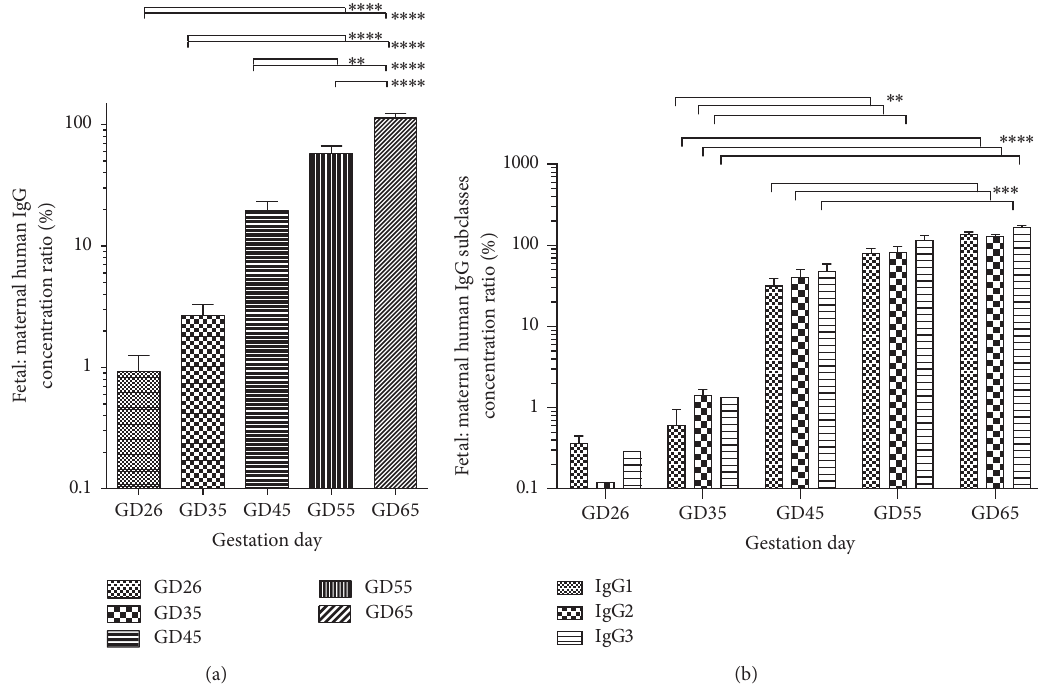
Figure 4: Fetal :maternal concentration ratio for total human IgG (a) and IgG subclasses (b) following hepatitis B immune globulin (HBIG) administration at different gestation ages. HBIG was administered intravenously at a dose of 100 IU/kg ( ∼ 7mg/kg) in pregnant guinea pigs at different gestation ages (GD, 𝑥 -axis). Fetal :maternal concentration ratios (shown as mean ± SEM) for the total IgG and IgG subclasses 1–3 increase exponentially with gestation age. Shown time points roughly correspond to the end of first trimester (GD26), middle and end of second trimester (GD35 and 45), and middle and end of third trimester (GD55 and 65). One- and two-way ANOVA with Bonferroni post hoc analyses were used to compare total human IgG and human IgG subclasses fetal : maternal concentration ratios in each gestation age; ∗∗ 𝑝 < 0.01 , ∗∗∗ 𝑝 < 0.001 , and ∗∗∗∗ 𝑝 < 0.0001 .